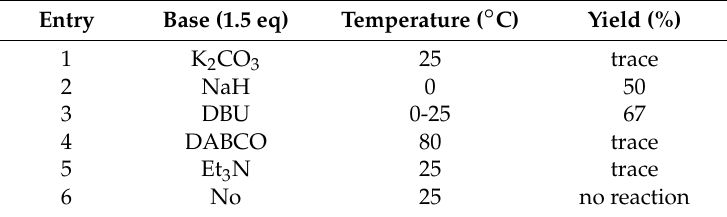
Table 2. Optimization of the reaction conditions for compound 11c .